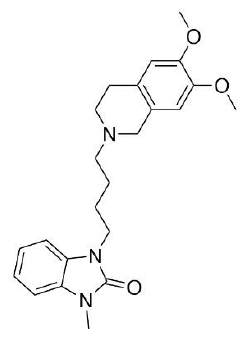
Figure 1. Chemical structure of 1-[4-(6,7-dimethoxy-1,2,3,4-tetrahydroisoquinolin-2-yl)butyl]-3-methyl-1,3-dihydro-1,3-benzimidazol-2-one (CM-398).